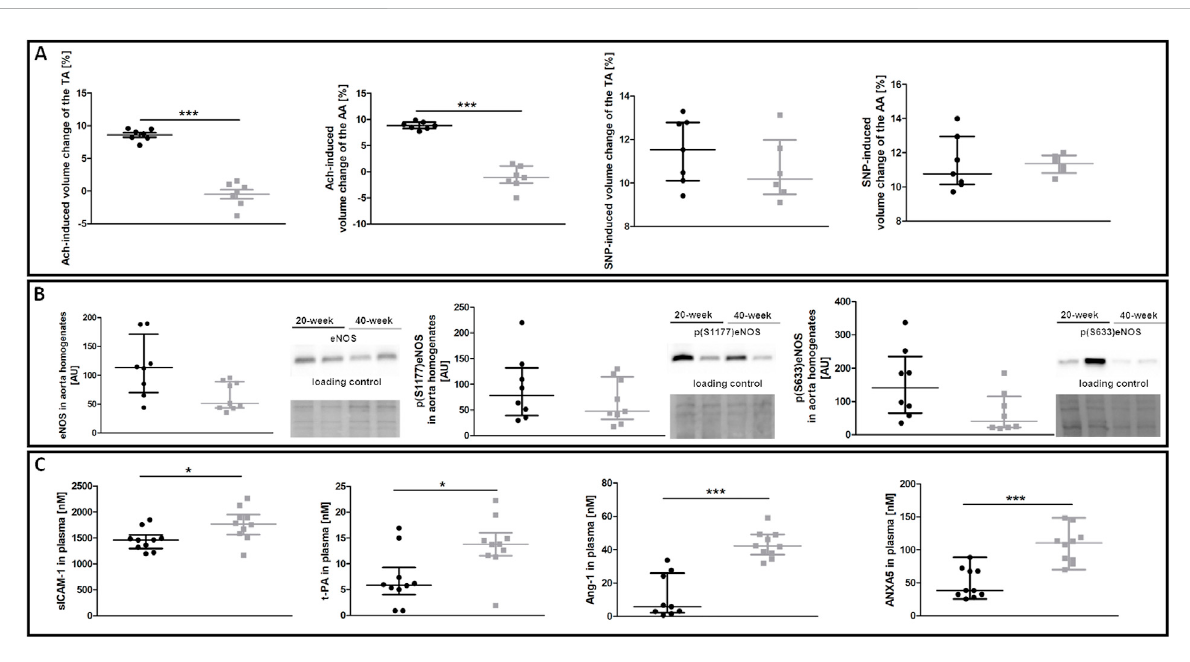
FIGURE 1 NO-dependent in vivo aorta function, eNOS phosphorylation and plasma endothelial dysfunction biomarkers in control untreated 20-week- old and 40-week-old BALB/c mice. Black symbols denote 20-week-old untreated control mice, and grey symbols denote untreated control 40- week-old mice. (A) MRI-based in vivo NO-dependent function of the aorta. The graphs show changes in the end-diastolic volume of the TA and AA 30 min after ACh or SNP administration ( n = 6 – 7). (B) The eNOS level and its absolute phosphorylation at S1177 and S633 are shown by representative western blots ( n = 8 – 9). (C) Changes in selected plasma endothelial dysfunction biomarkers ( n = 9 – 10). All data were compared with an unpaired Student ’ s t -test except plasma Ang-1 levels that were compared with a non-parametric Mann-Whitney U test. Results are shown as the median and IQR. Key: * p < 0.05; *** p <